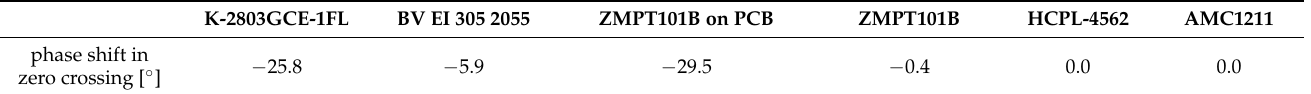
Table 3. The phase shift in the signal zero crossing of the input and output